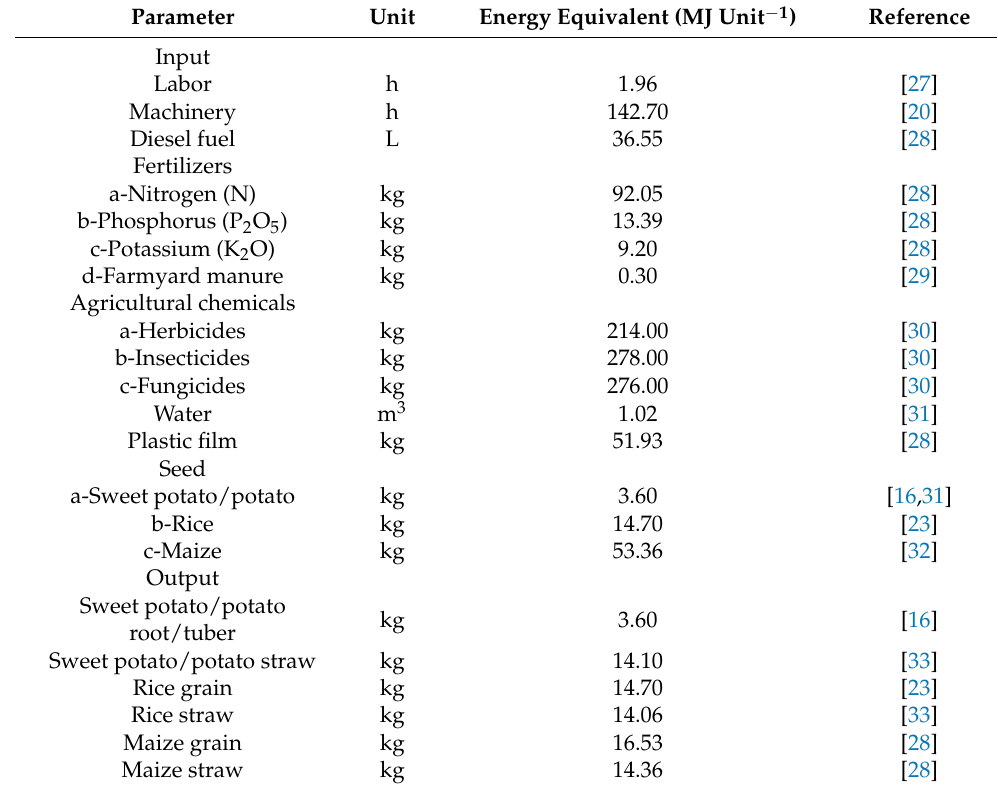
Table 2. Energy equivalents of the input and output in sweet potato, potato, rice, and maize production.